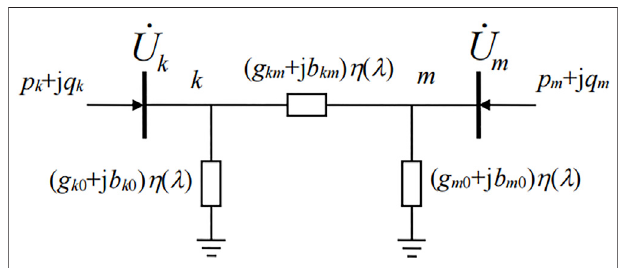
FIGURE 3 | Equivalent circuit of type k-m for the grid breaking